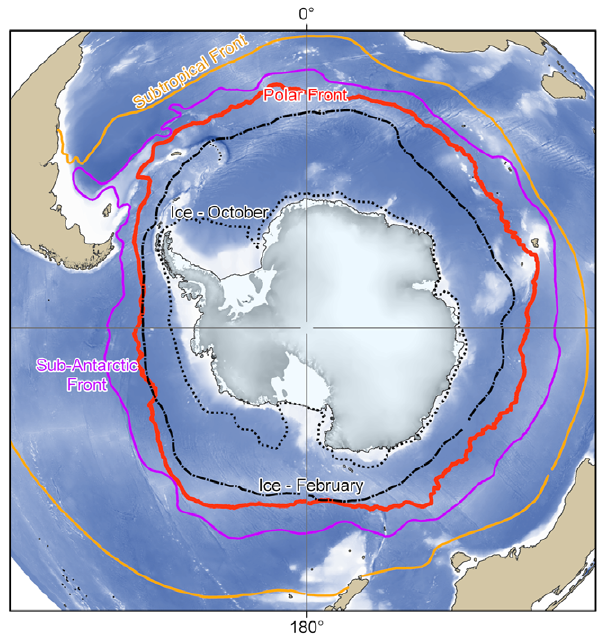
Figure 3. Major oceanographic features of the Southern Ocean. Mean positions of the major oceanographic fronts and summer and winter ice extents for the Southern Ocean [7,14].